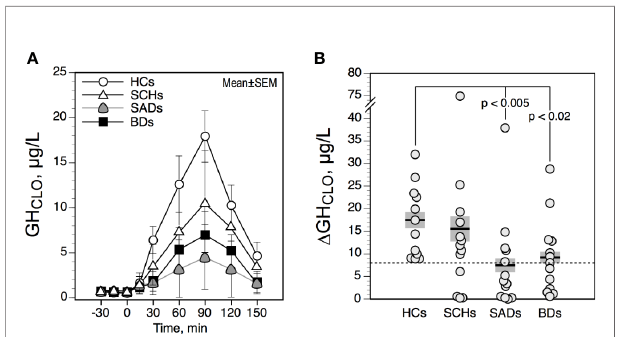
FIGURE 2 | Time course (A) and maximum increment (B) in serum growth hormone (GH) above baseline after 0.375 mg of clonidine PO in controls and patients. The solid horizontal lines indicate the group mean; the shaded areas represent ± SEM. HCs, healthy control subjects; SCHs, patients with paranoid schizophrenia; SADs, patients with schizoaffective disorder; BDs, patients with bipolar